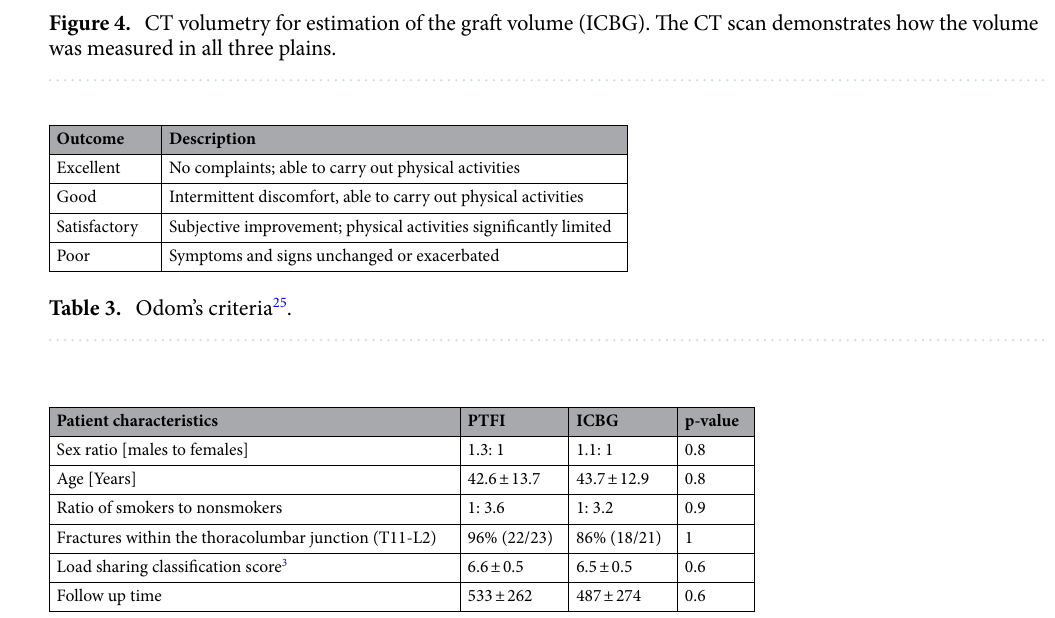
Table 4. Patient characteristics.